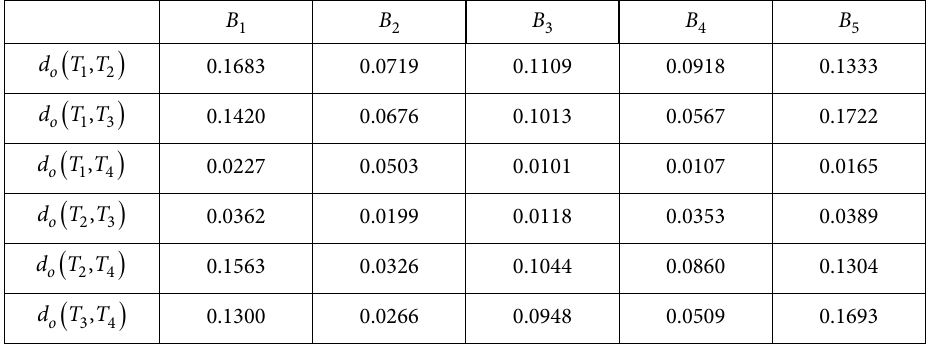
Table 12. Distance between each of the two alternatives